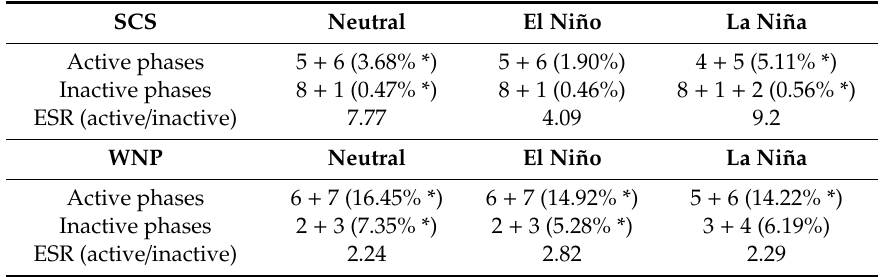
Table 1. Daily genesis rate (DGR) of tropical cyclone (TC) genesis during the active and inactive Madden–Julian Oscillation (MJO) phases, and related enhancement-to-suppression ratio (ESR) over the South China Sea (SCS) and Western North Pacific (WNP) for di ff erent El Niño-Southern Oscillation (ENSO) conditions during June–November over the period of 1979–2016. SCS